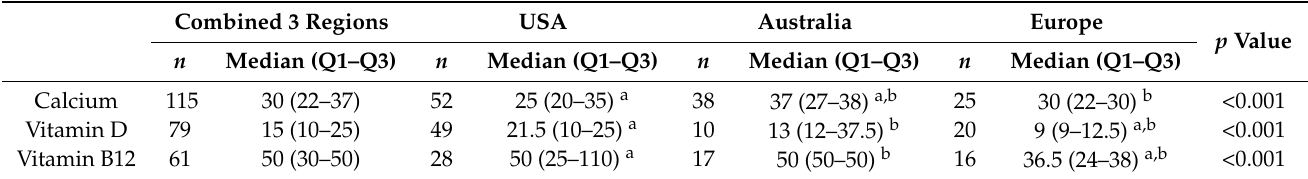
Table 2. Median (Q1–Q3) values 1 of calcium, vitamin D and vitamin B12 levels used in fortification for fortified products, by world region.